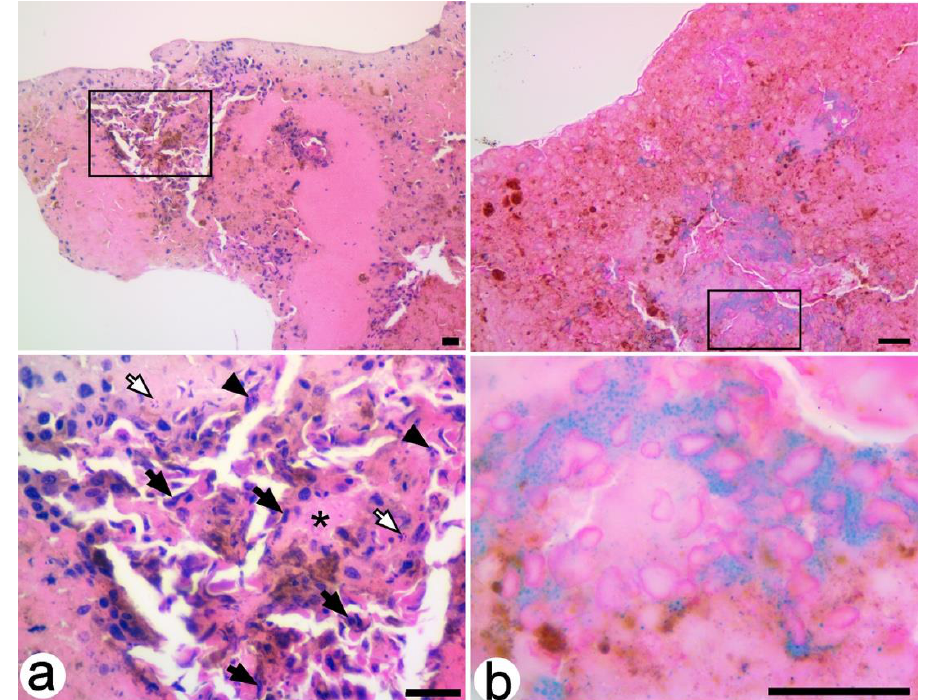
Figure 4. Histopathology of a B16F10 xenograft three days after SaMNP treatment. Area of tumor necrosis ( a ) with foci of melanoma cells presenting pyknotic (black arrows) or fragmented (black arrowheads) nuclei, apoptotic bodies (white arrows), and extracellular exudates (black star). Intracytoplasmic Perl’s positive iron deposits with perinuclear disposition in the tumor necrosis area ( b ). Hematoxylin & eosin ( a ) and Perl’s Prussian blue ( b ) staining. Bar = 25 µm.